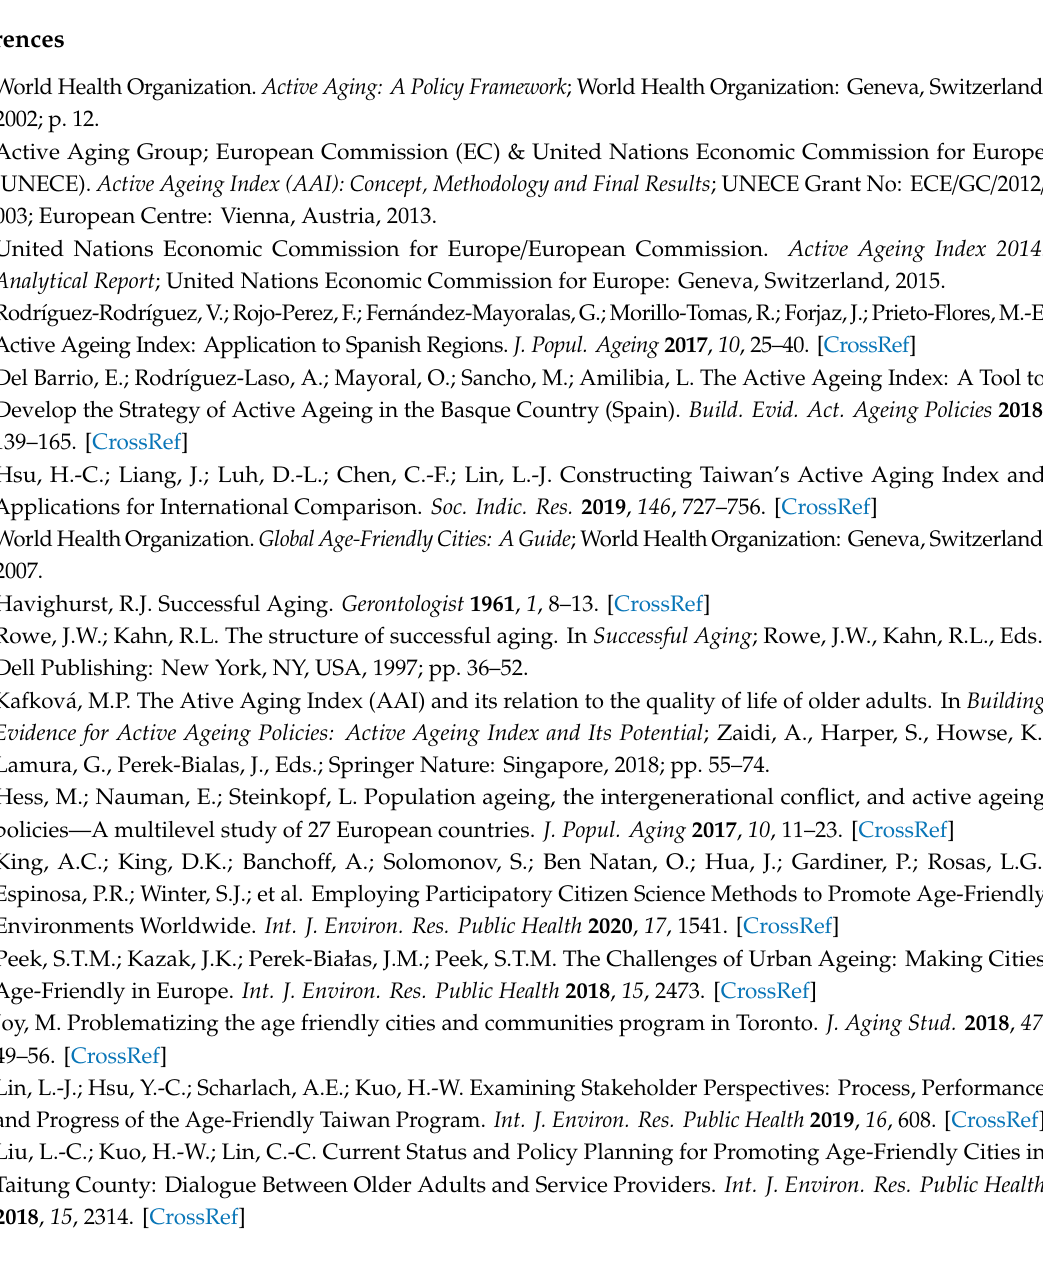
Figure S1: Well-being by active aging and age friendly city clusters; Table S1: The sample size and the backgrounds of the cities in 2017; Table S2: Life satisfaction with city and individual factors of older adults (age 55 + ); Table S3: Quality of life with cities and individual factors of older adults (aged 65 + ); Table S4: Association of active aging city typologies with individuals’ age, sex, and health by multinomial logistic regression (odds ratios); Table S5: Association of age friendly city typologies with individuals’ age, sex, and health by multinomial logistic regression (odds